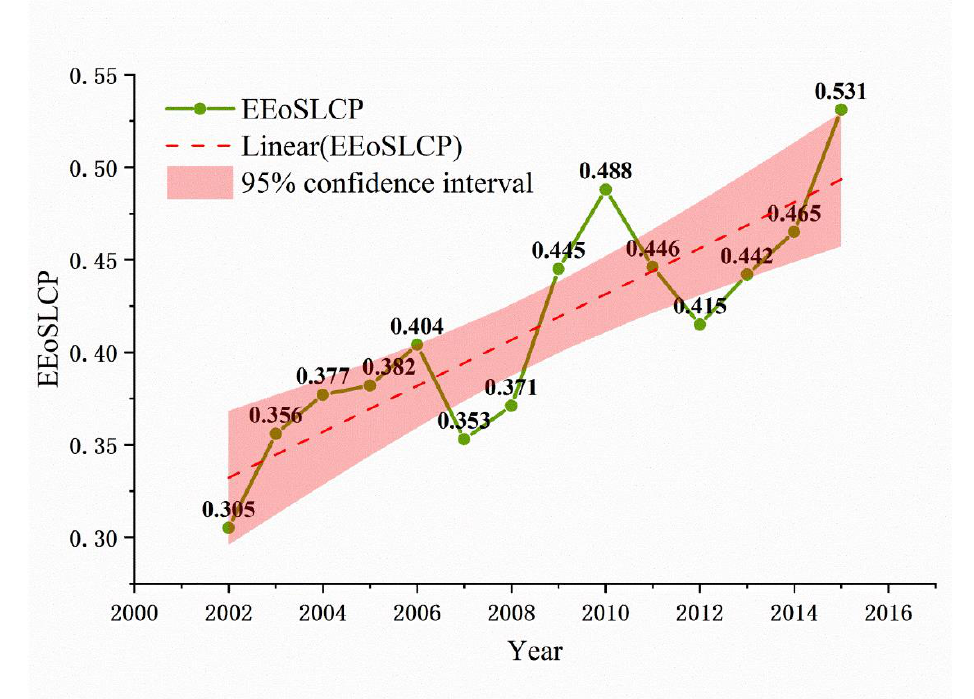
Figure 4. The average value of EEoSLCP, 2002 to 2015. Figure 5 is obtained after kernel density calculation by Matlab R2018a (Matlab soft- ware from MathWorks, Inc, USA).